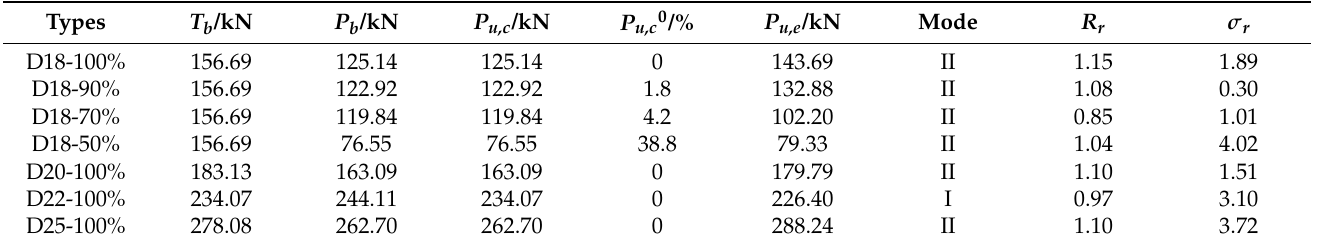
Table 6. Prediction